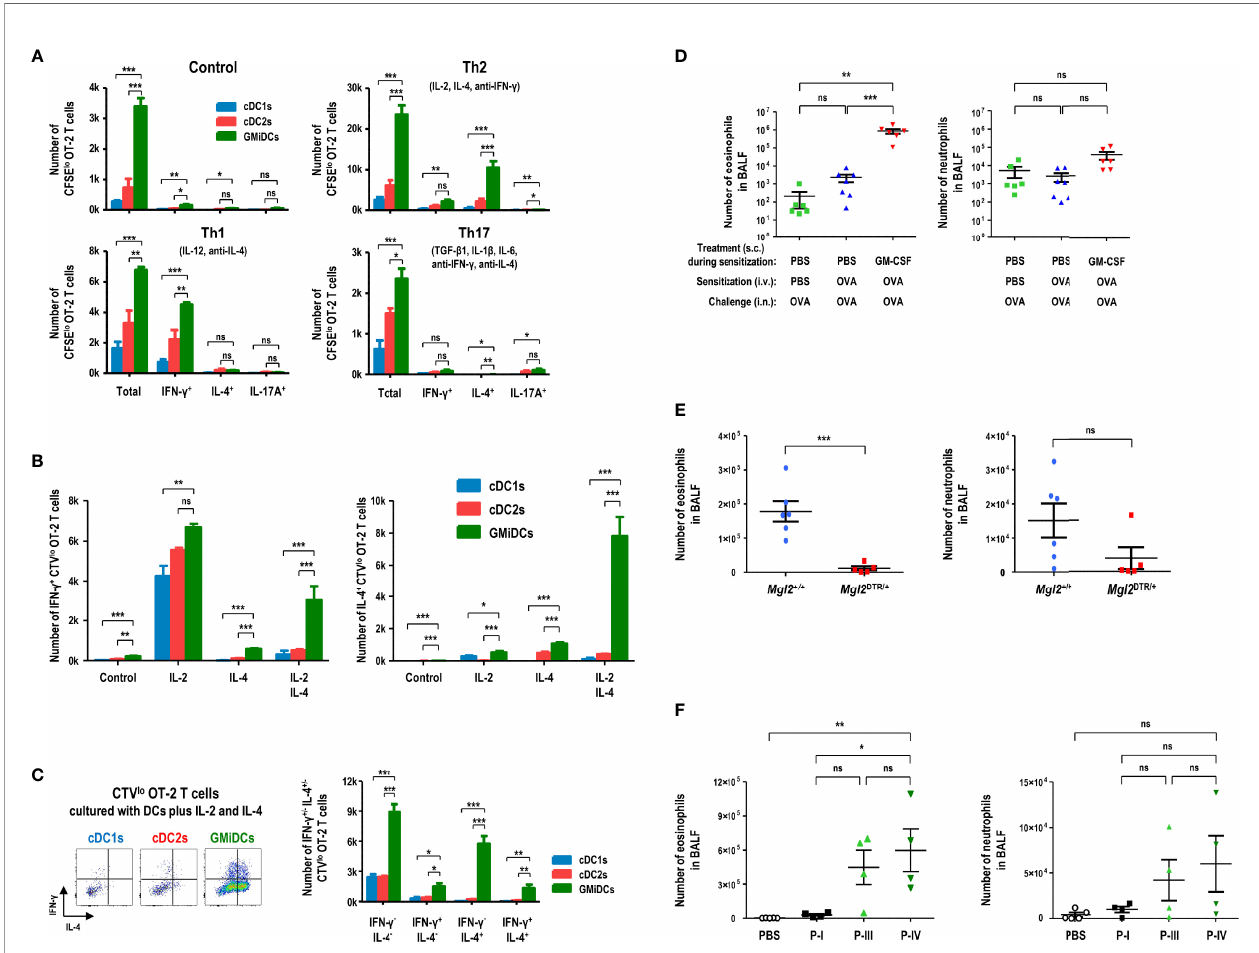
FIGURE 5 | Splenic GMiDCs ef fi ciently polarize Th2 cells and induce allergic sensitization in response to blood-borne antigen. Antigen-presenting splenocytes are isolated from GM-CSF-treated mice at 1 hour after the intravenous injection of OVA and cultured at an APC to T cell ratio of 1:5. (A) Proliferation and Th polarization of CFSE-labeled naive CD4 + OT-2 T cells stimulated by splenic DC subsets under the respective conditions (Th1: 10 ng/ml IL-12, 5 m g/ml anti-IL-4; Th2: 10 ng/ml IL-2, 10 ng/ml IL-4, 5 m g/ml anti-IFN- g ; Th17: 2 ng/ml TGF- b , 10 ng/ml IL-1 b , 20 ng/ml IL-6, 5 m g/ml anti-IFN- g , 5 m g/ml anti-IL-4). Data are shown in mean ± SEM (n = 3 or 4 replicates) from 3 independent experiments. (B) Numbers of proliferated IFN- g + Th1 (left graph) and IL-4 + Th2 (right graph) CellTrace Violet (CTV) lo CD4 + OT-2 T cells stimulated by splenic DC subsets under the conditions containing 10 ng/ml IL-2 and/or 10 ng/ml IL-4. Data are shown in mean ± SEM (n = 3 or 4 replicates) from 3 independent experiments. (C) Flow cytograms and graphs showing numbers of proliferated IFN- g + and/or IL-4 + CTV lo CD4 + OT-2 T cells stimulated by splenic DC subsets under the condition containing IL-2 and IL-4. Data are shown in mean ± SEM (n = 3 or 4 replicates) from 3 independent experiments. (D) Graphs showing the numbers of eosinophils (left) and neutrophils (right) in BALF of the mice treated to cause OVA-induced allergic airway in fl ammation as in Supplementary Figure 17 . Data are shown in mean ± SEM (n = 6 or 7 mice for each condition). (E) Graphs showing the numbers of eosinophils (left) and neutrophils (right) in BALF of the GM-CSF/DT- treated Mgl2 +/+ and Mgl2 DTR/+ mice following blood-borne OVA sensitization and OVA-induced allergic airway in fl ammation as in Supplementary Figure 18 . Data are shown in mean ± SEM (n = 5 or 6 mice for each genotype). (F) Graphs showing the numbers of eosinophils (left) and neutrophils (right) in BALF of the mice treated with GM-CSF, adoptive transfer with blood-borne OVA-sensitized splenic CD11b + CD115 hi cell subsets, and OVA-induced allergic airway in fl ammation as in Supplementary Figure 19 . Data are shown in mean ± SEM (n = 4 or 5 mice for each condition). *p ≤ 0.05; **p ≤ 0.01; ***p ≤ 0.001; ns, not signi fi cant; one-way (D, F) or two-way (A-C) ANOVA test; Student ’ s t -test (E)